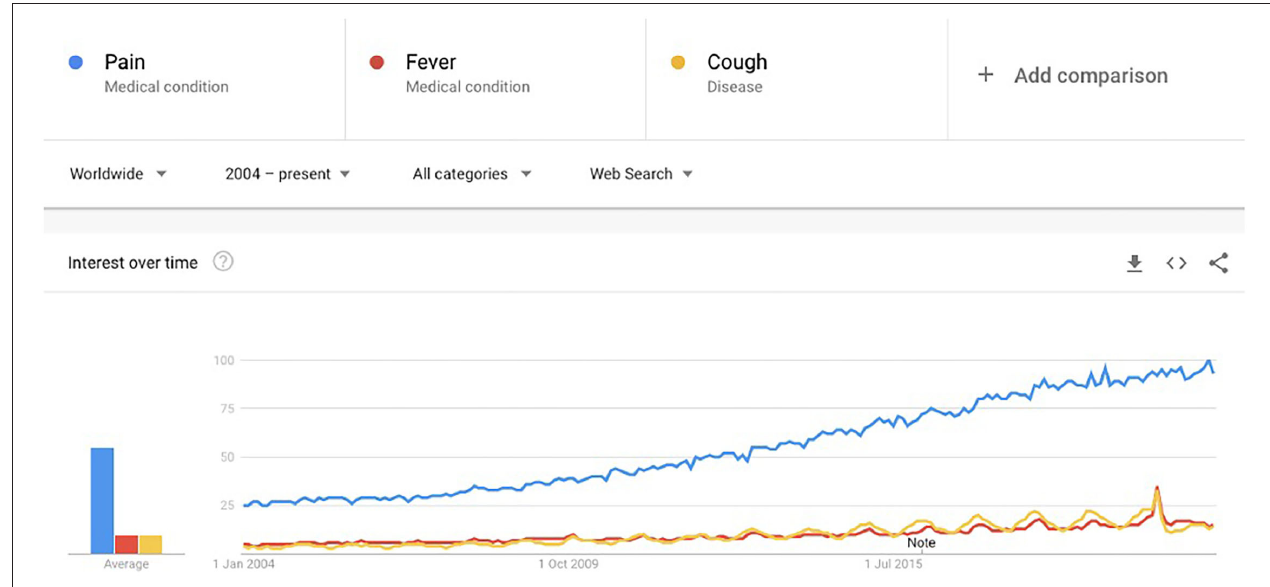
FIGURE 1 | Google trends for medical condition search term “pain” compared to other common symptoms “fever” and “cough.” X-axis represents time in years. Y-axis numbers represent the search interest relative to the highest point on the chart (100 is the peak popularity for the term, 50 indicates the term is half as popular, and 0 means there was insufficient data for the